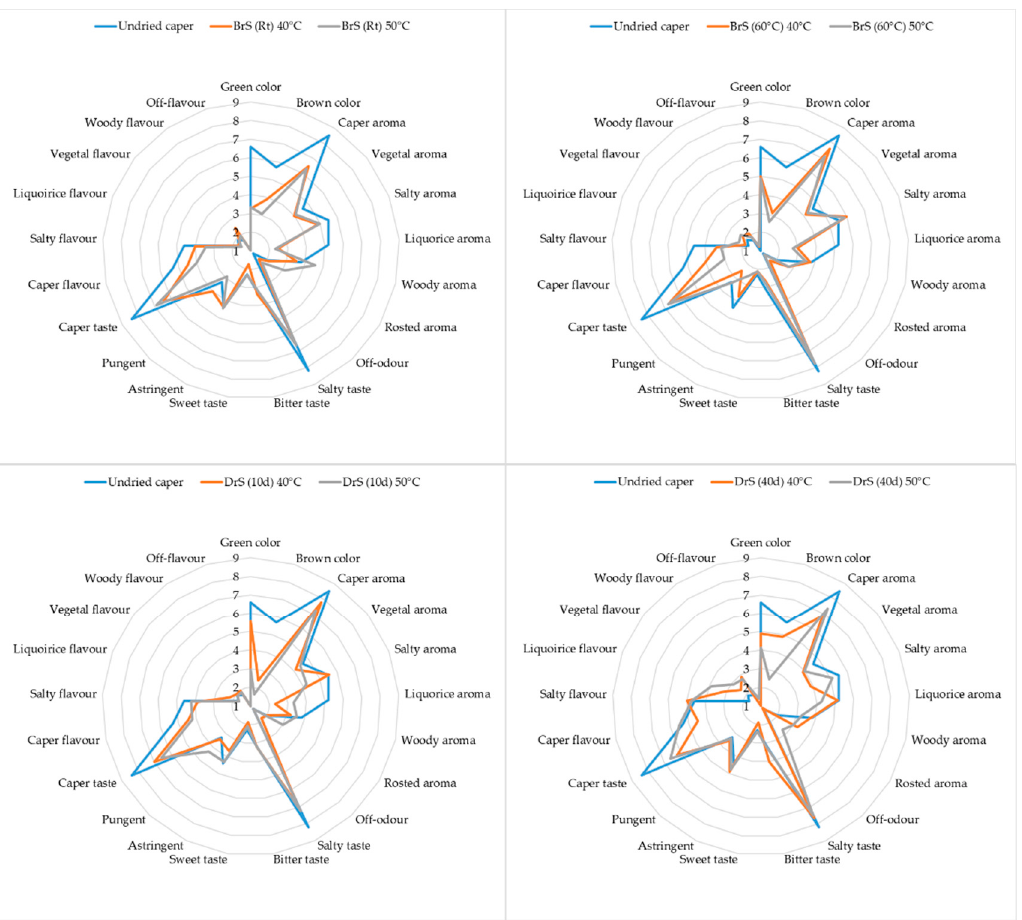
Figure 4. QDA sensory plot of caper powders obtained from the different trials in comparison with undried capers.